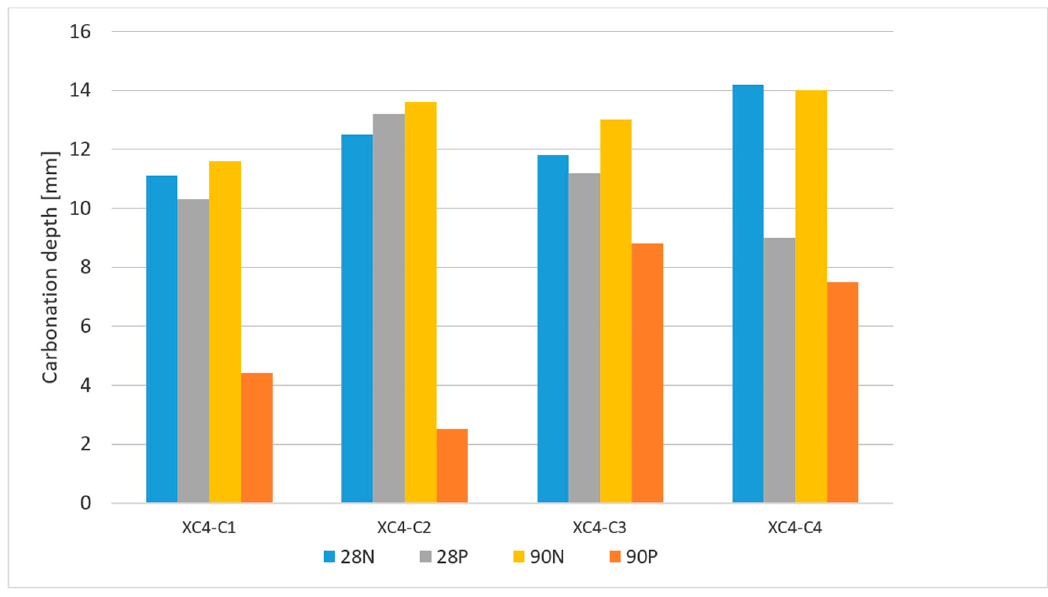
Figure 6. Carbonation depth—concretes XC4.